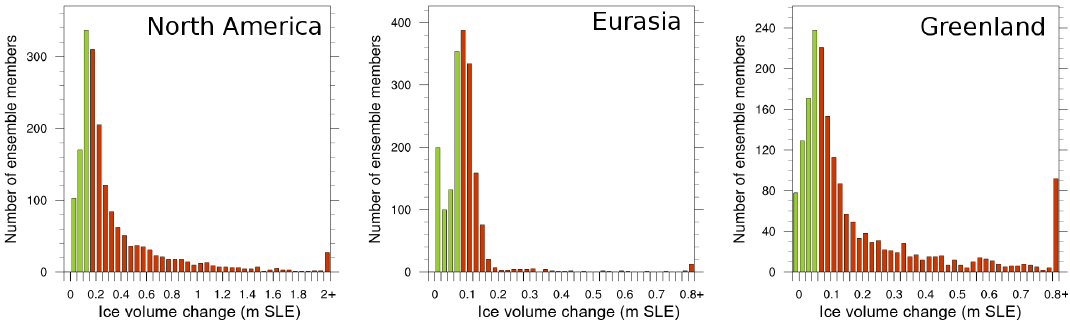
Figure 10. The distribution of ice volume change over NA, EA, and Greenland, between 1700 and 1980CE in 2000 ensemble runs. Green bars represent the selected 500 ensemble members, and red bars represent the rest. SLE stands for sea level equivalent.